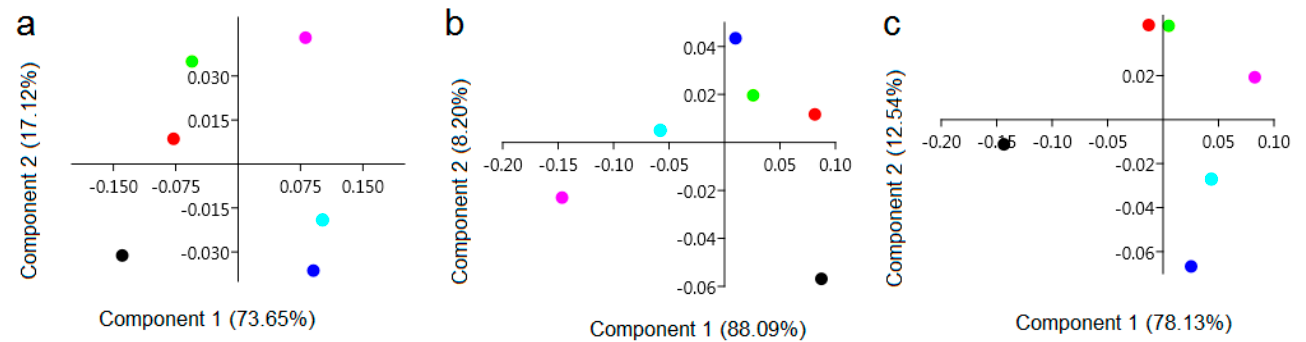
Figure 3. PCA analysis of FT-Raman spectra of wheat grains grown in 2017 ( a ), 2018 ( b ), 2019 ( c ); crop protection variants: (1) control (black dot); (2) intensive (red dot); (3) extensive (green dot); (4) PlanTonic BIO (blue dot); (5) PlanTonic BIO + Natural Crop (azure dot); (6) PlanTonic BIO + Biofol Plex (pink dot).